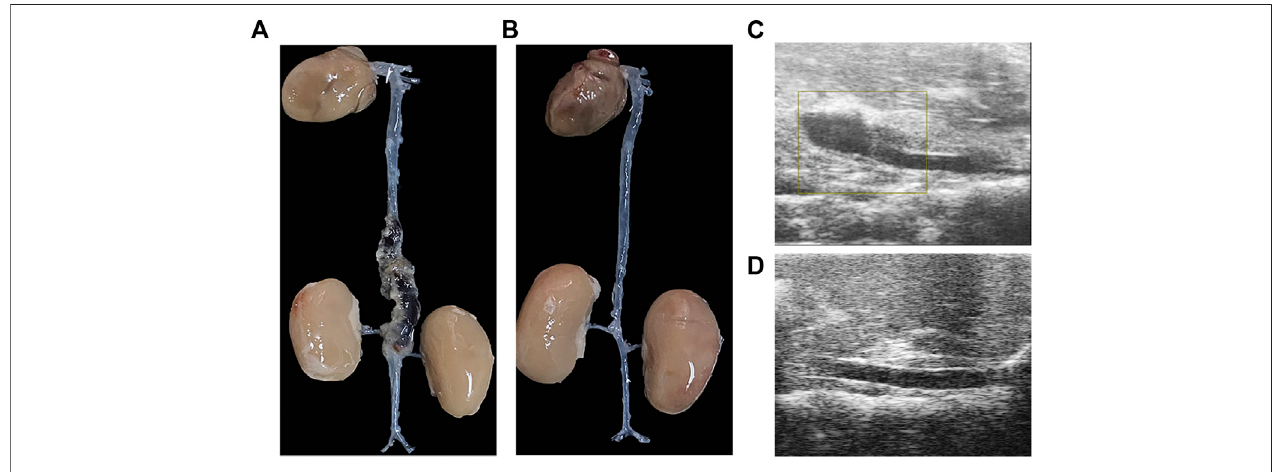
FIGURE1| Theaorticdissection induced byangiotensin IIinfusion. (A) Gross morphologyofaortic dissection. (B) Gross morphologyofnormalblood vessels. (C) Ultrasound image of aortic dissection in the experimental group. (D) Ultrasound image of normal vessels in the control